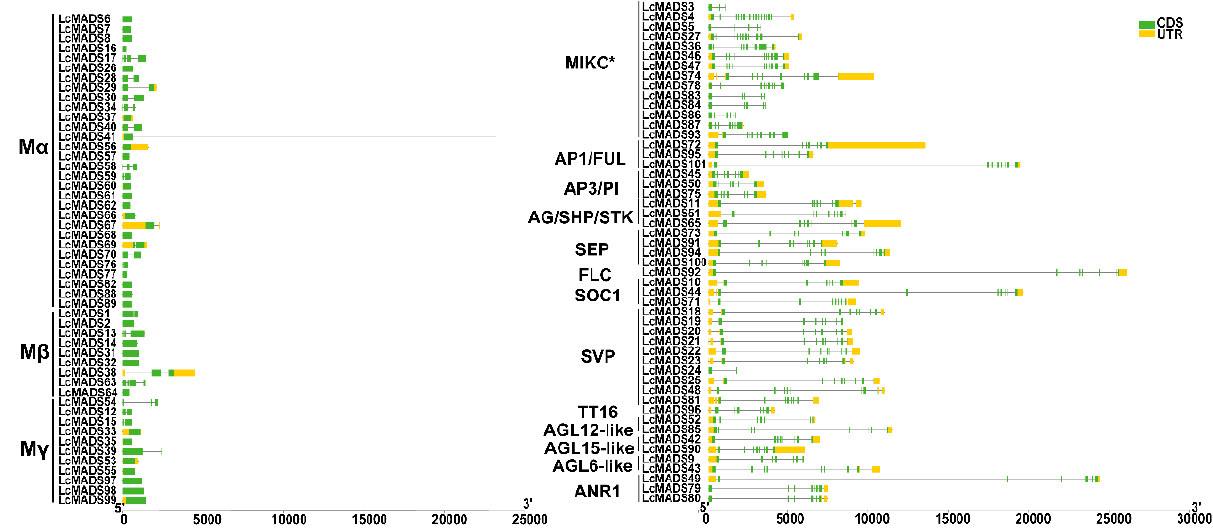
Figure 4. Structural analysis of MADS-box transcription factor genes in litchi. Yellow boxes indicate untranslated 5 ′ - and 3 ′ -regions, while green boxes and black lines indicate exons and introns, respectively. Type I genes are shown on the left and type II genes are shown on the right.